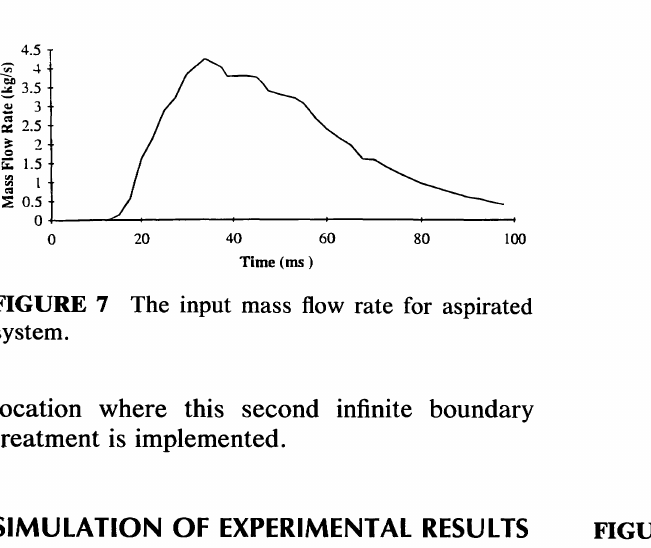
FIGURE 9 Comparison of computed and measured force on drum for aspirated system.